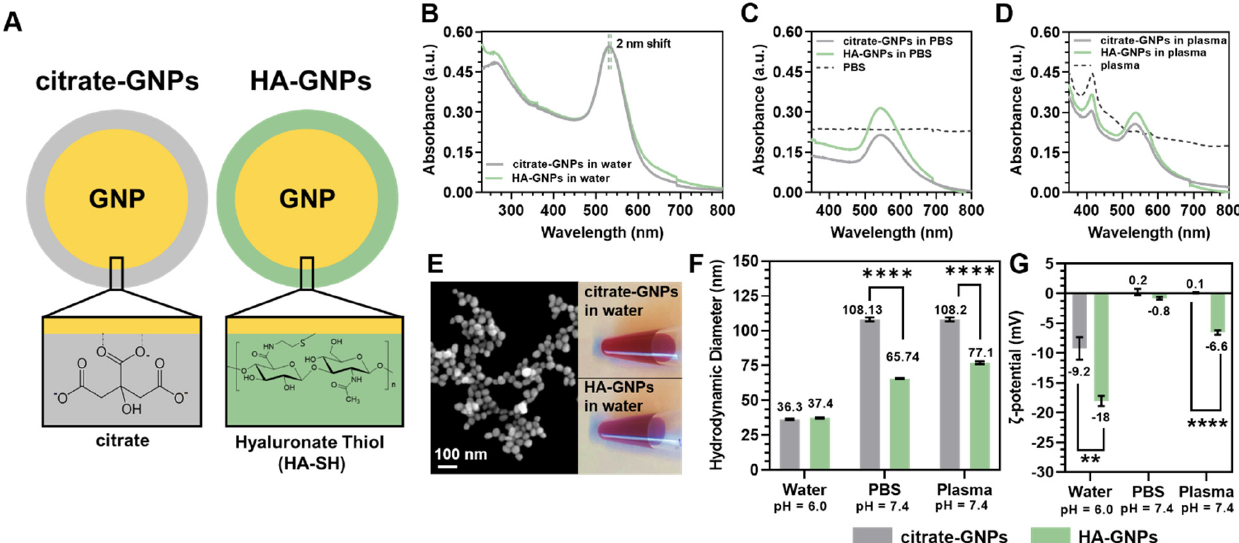
Figure 1. ( A ) Schematic diagram of GNPs stabilized with citrate or surface passivated with thiol-modified hyaluronic acid (where the number of monomers n is ~3). Absorbance spectra of citrate-GNPs (gray line) and HA-GNPs (green line) dispersed in ( B ) water, ( C ) PBS, and ( D ) plasma. ( E ) SEM image of the particles after synthesis (130,000×) and optical photographs of citrate-GNPs and HA-GNPs. Measurements of ( F ) hydrodynamic diameter and ( G ) ζ -potential of citrate-GNPs and HA-GNPs dispersed in Milli-Q water, PBS, and porcine plasma. Significance is calculated using a multiple unpaired t test (** p < 0.005, **** p < 0.0001).